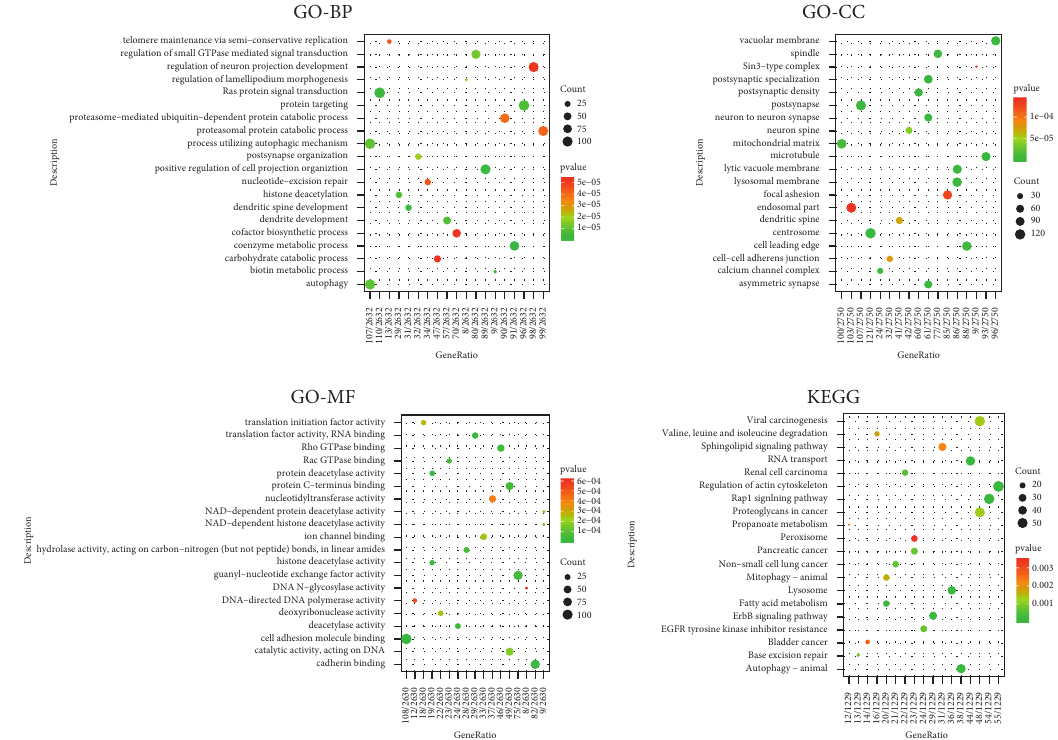
Figure 2: Bubble chart of GO-KEGG enrichment results. The more the genes in each enrichment item, the bigger the bubble, and the P value from high to low corresponds to the color from red to